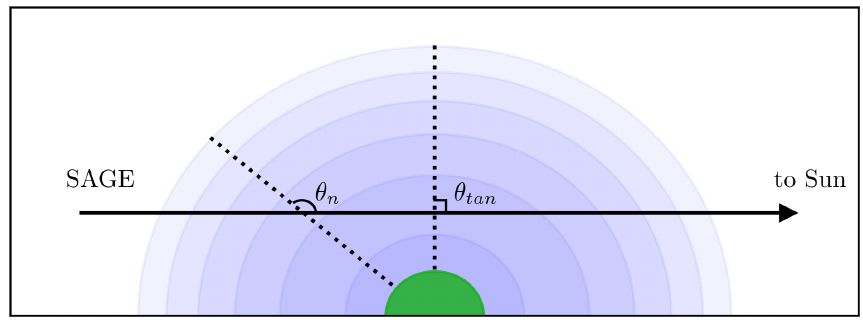
Figure 2. Geometry of a SAGE III occultation. The green semi-circle represents the Earth, and the blue semi-circles represent layers of the atmosphere. The angle θ tan is the SZA at the tangent point, and the angle θ n is the SZA angle for a shell at altitude n .